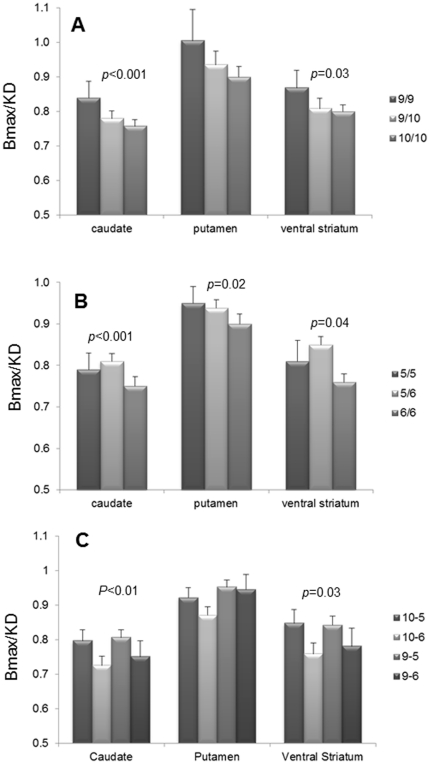
Measures of DAT availability (Bmax/KD) in genotype groups.Bars correspond to mean DAT availability and standard errors of means in 3′-UTR-genotype (A), intron8-genotype (B) and haplotype groups (C) in caudate, putamen and ventral striatum. Significant differences between the mean values are indicated (p<0.05). Bmax/KD values (Y-axis) correspond to DAT binding potential.